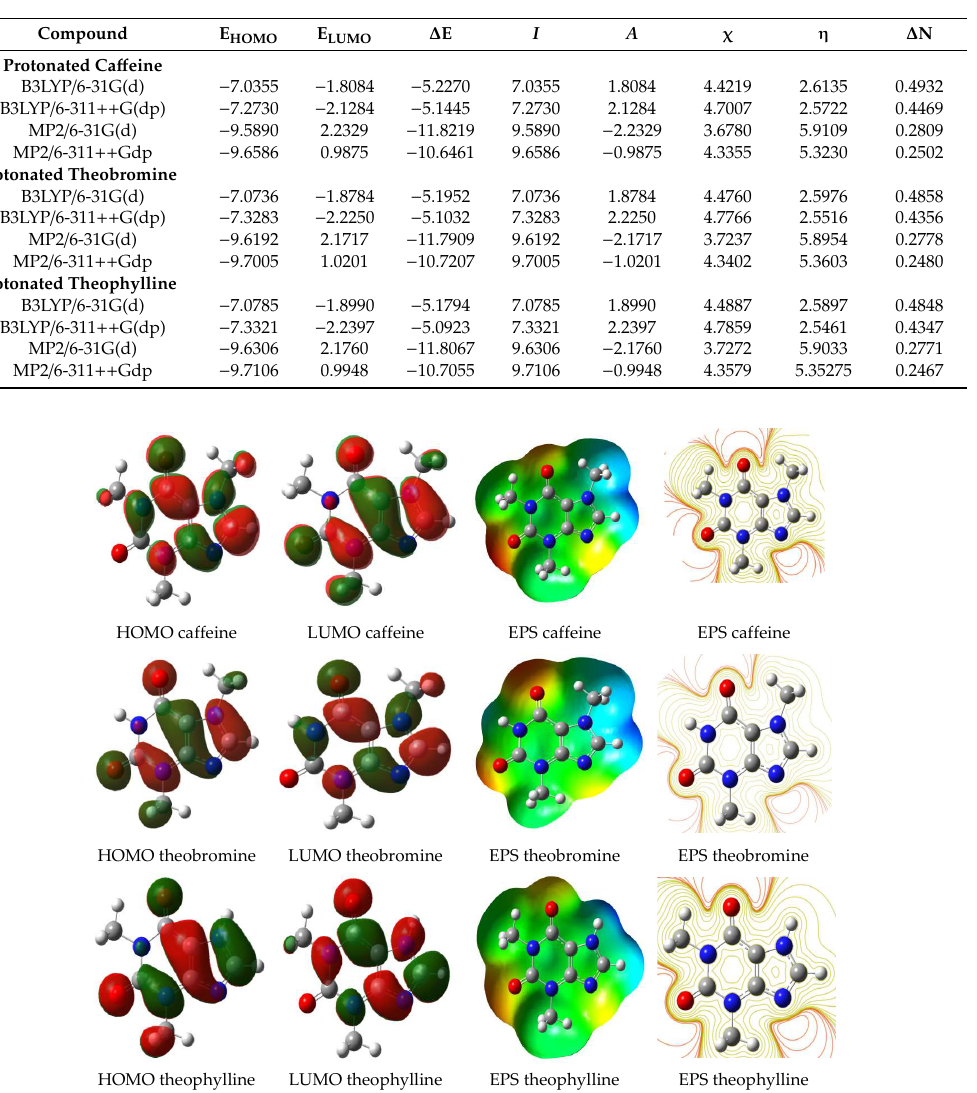
Figure 2. Visualization of highest occupied molecular orbitals–lowest unoccupied molecular orbitals (HOMO–LUMO) energies and electrostatic potential of ca ff eine and its